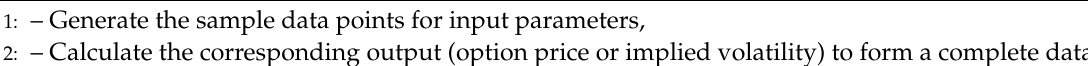
Algorithm 1 Model framework